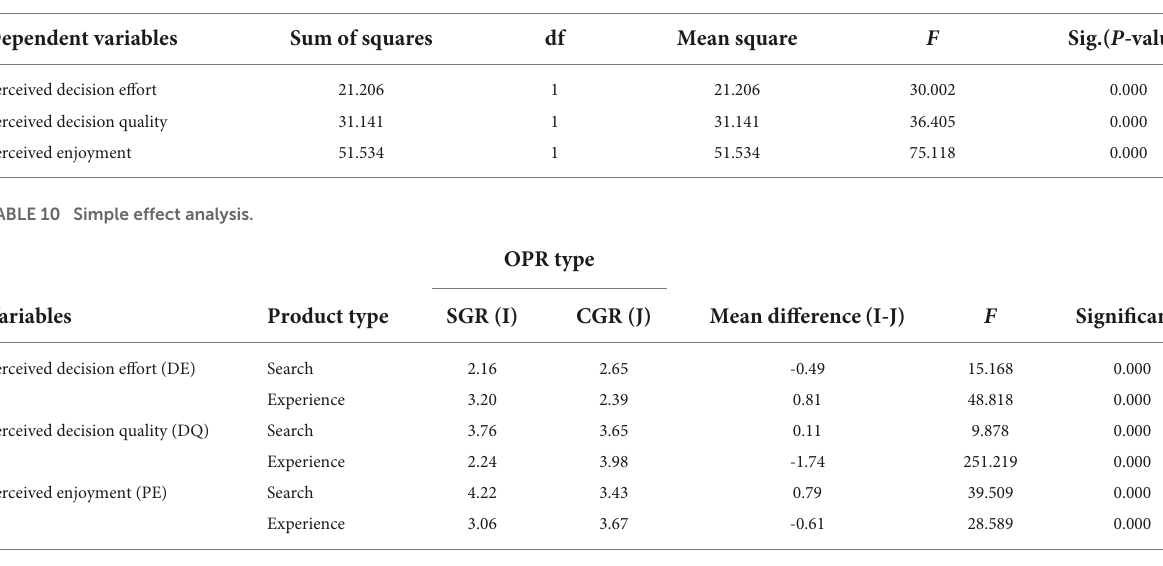
TABLE 9 MANOVA results.